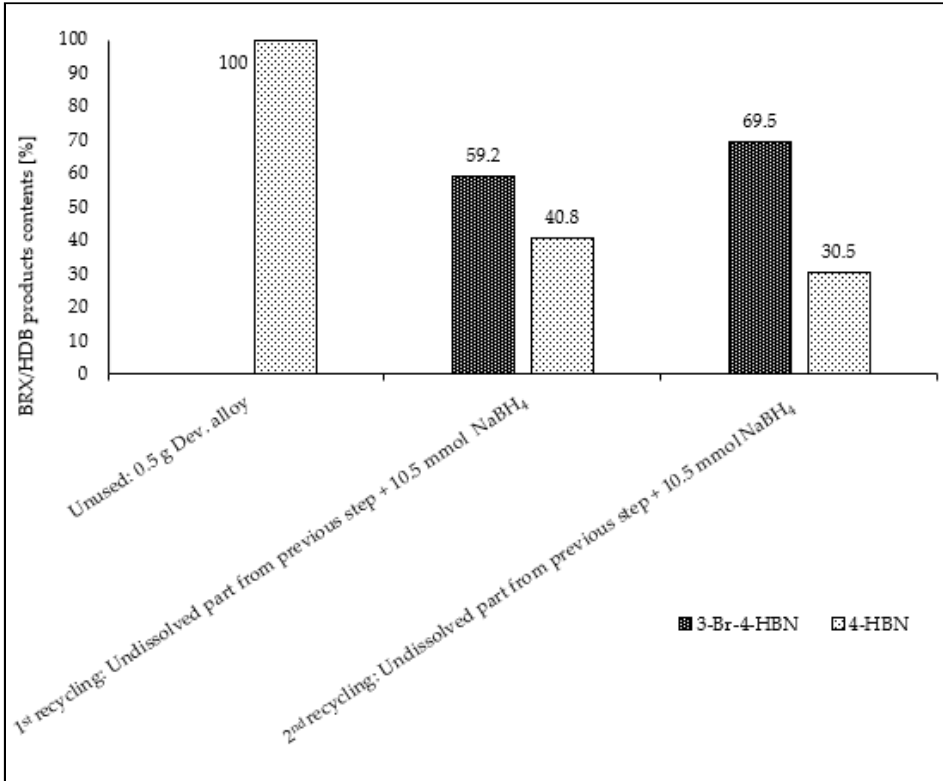
Figure 7. Effect of Dev. alloy recycling on the HDB of BRX using NaBH 4 after 18 h of vigorous stirring. Dev. alloy was added to the solution containing 2.5 mmol BRX + 50 mmol NaOH in 100 mL H 2 O.